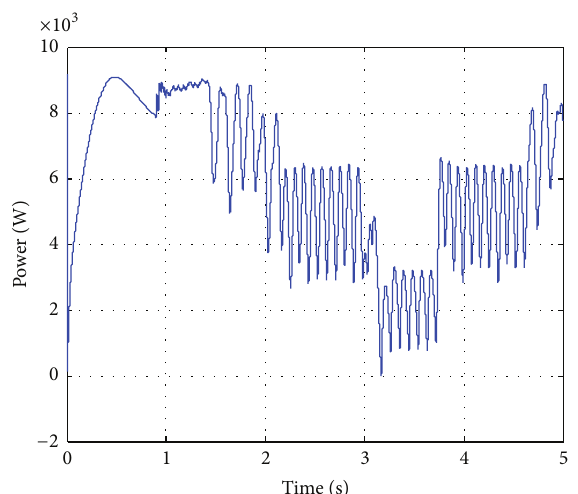
Figure 19: Inverter voltage waveform.